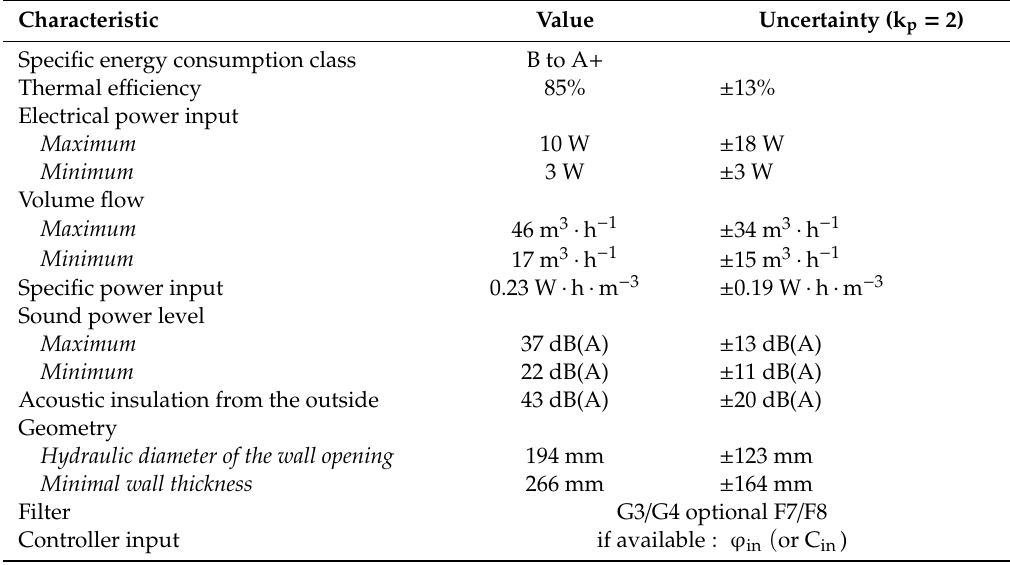
Table 1. Average “data sheet” of push-pull devices based on 31 devices available for the German market